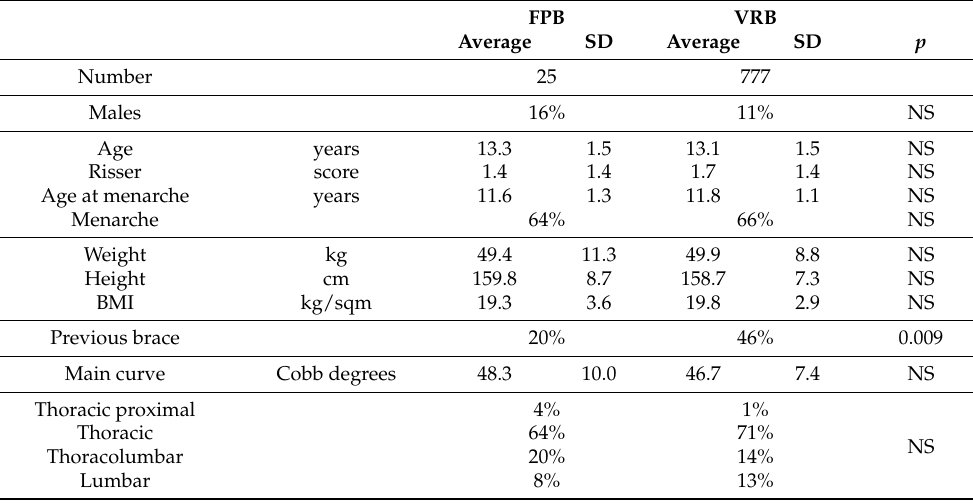
Table 1. Baseline data with all possible confounders. Management of the statistically significant differences is explained in the